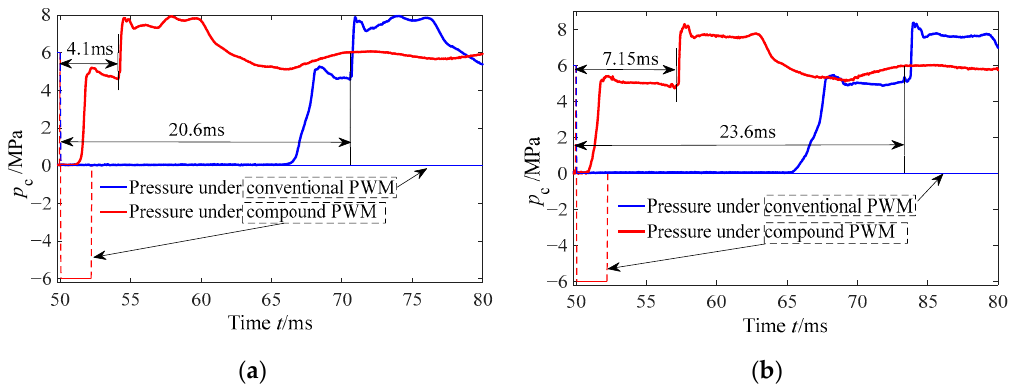
Figure 10. Comparisons of the pressure in the control chamber during the de-energized stage at the frequency of 10 Hz: ( a ) The adjustable maximum opening is 0.2 mm; ( b ) The adjustable maximum opening is 0.4 mm.